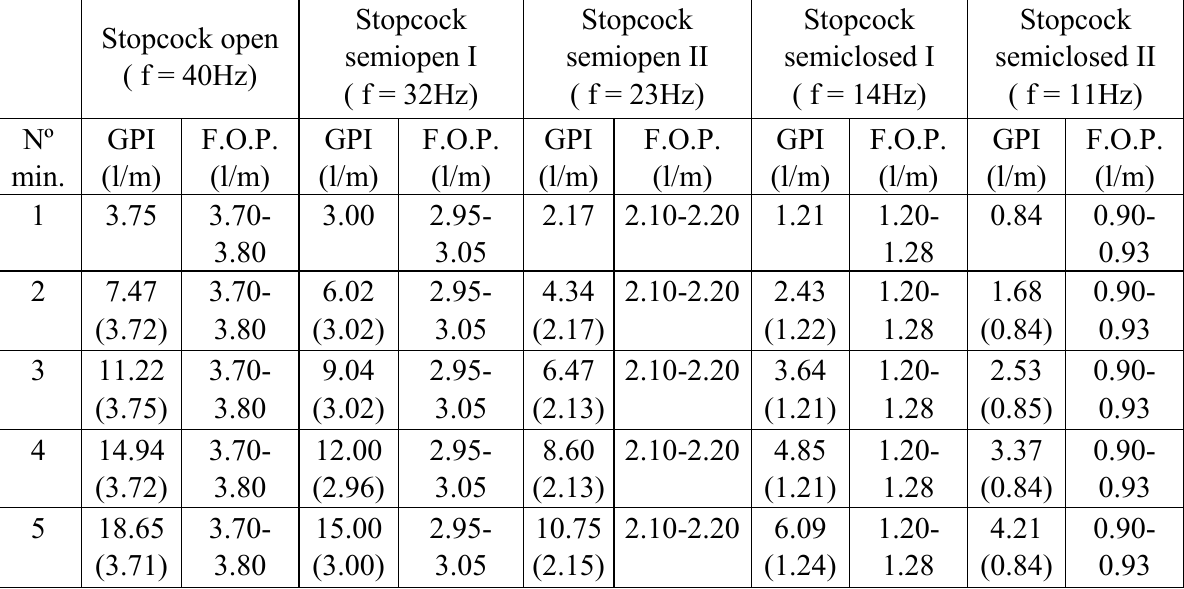
Table 1 . Summary table giving different flow rate